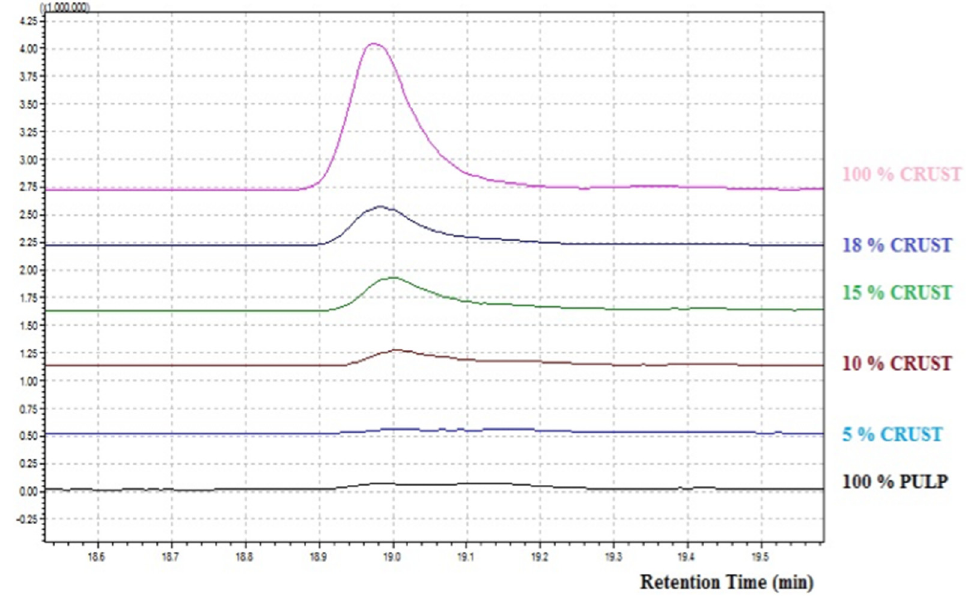
Figure 1. SPME ‐ GC ‐ MS, 5 ‐ Methyl ‐ 2 ‐ hexanol identified in 6 different percentages of grated PR. Figure 1. SPME-GC-MS, 5-Methyl-2-hexanol identified in 6 different percentages of grated